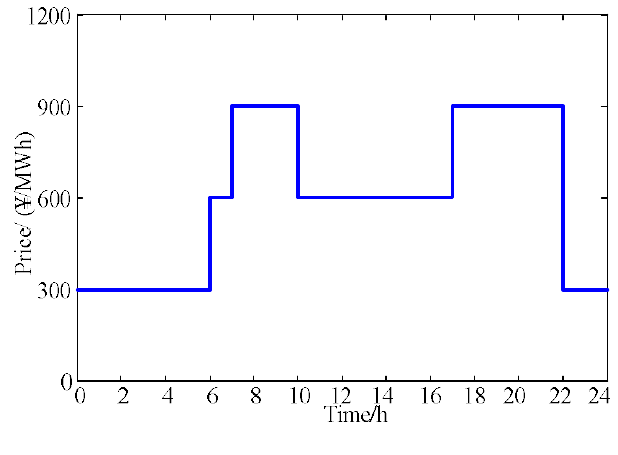
Figure 6. Prediction of wind power in a typical day.